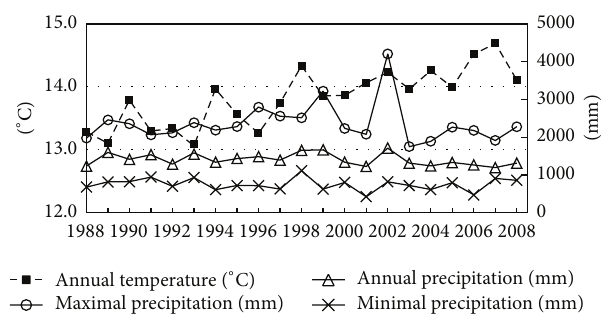
Figure 3: Research diagram for data handling and analysis.